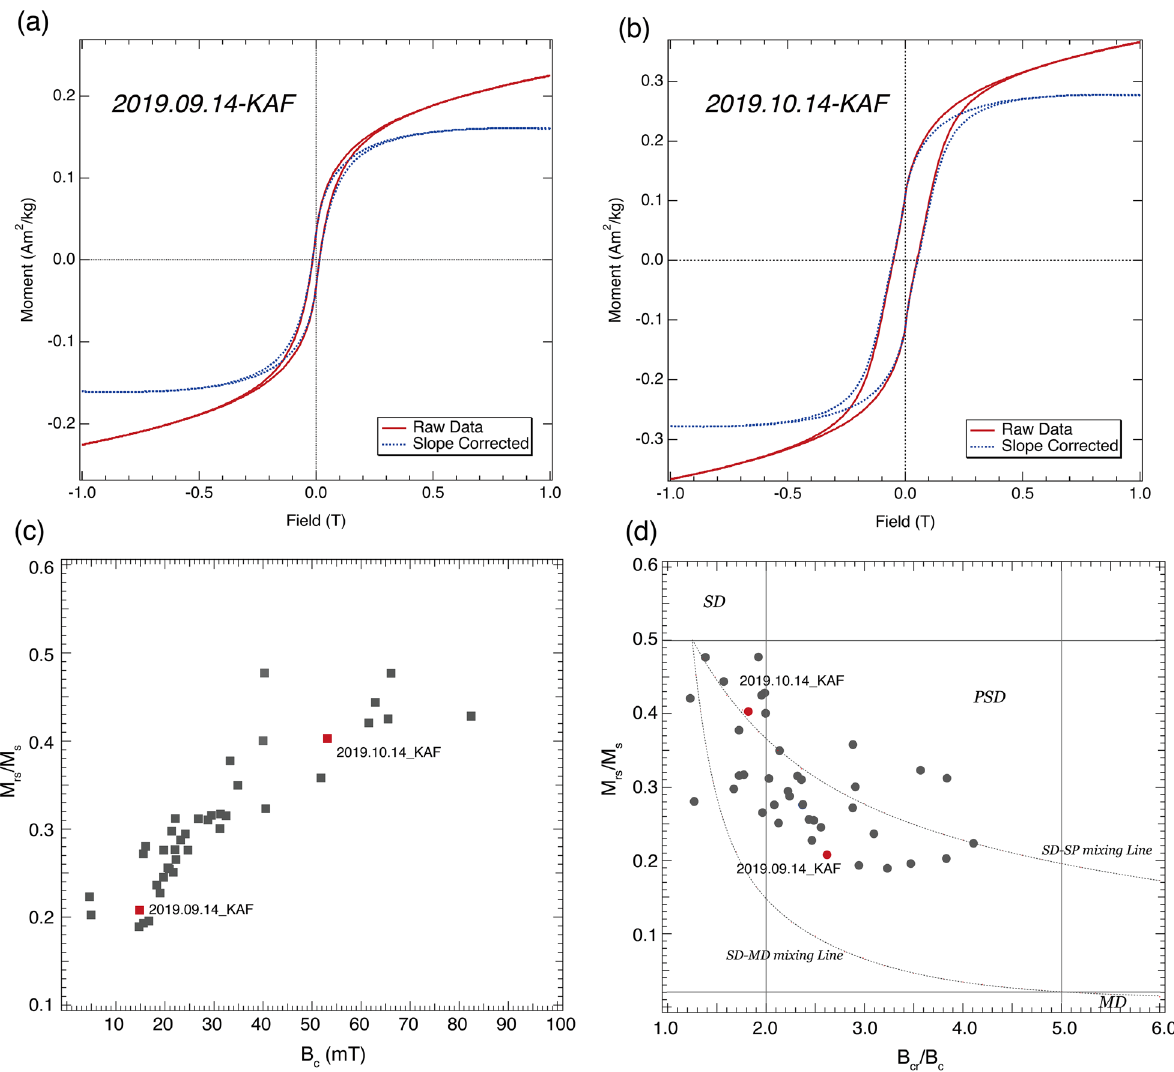
Fig. 2 Results of hysteresis measurement. a , b Examples of hysteresis loops. The red solid line is the measured hysteresis loop (raw data). The blue dashed line is the corrected loop for the effect of paramagnetic minerals. c Ratio of the saturation remanent magnetization to saturation magnetization (M rs /M s ) vs. coercivity (B c ). d M rs /M s vs. coercivity of remanence to coercivity (B cr /B c ). The upper left in the plot is single-domain (SD) region, while the lower right is closer to the multi-domain (MD) grain size. The two dotted lines are the SD–superparamagnetic (SP) mixing line (top) and the MD–SD mixing line (bottom) (Dunlop 2002a,